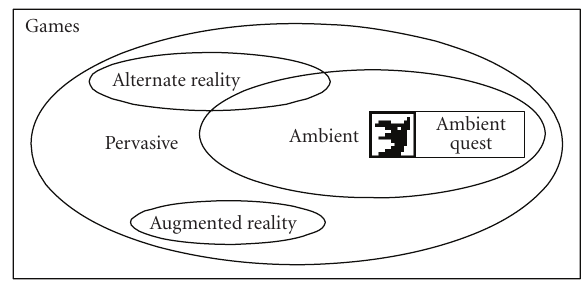
Figure 2: Pervasive and ambient